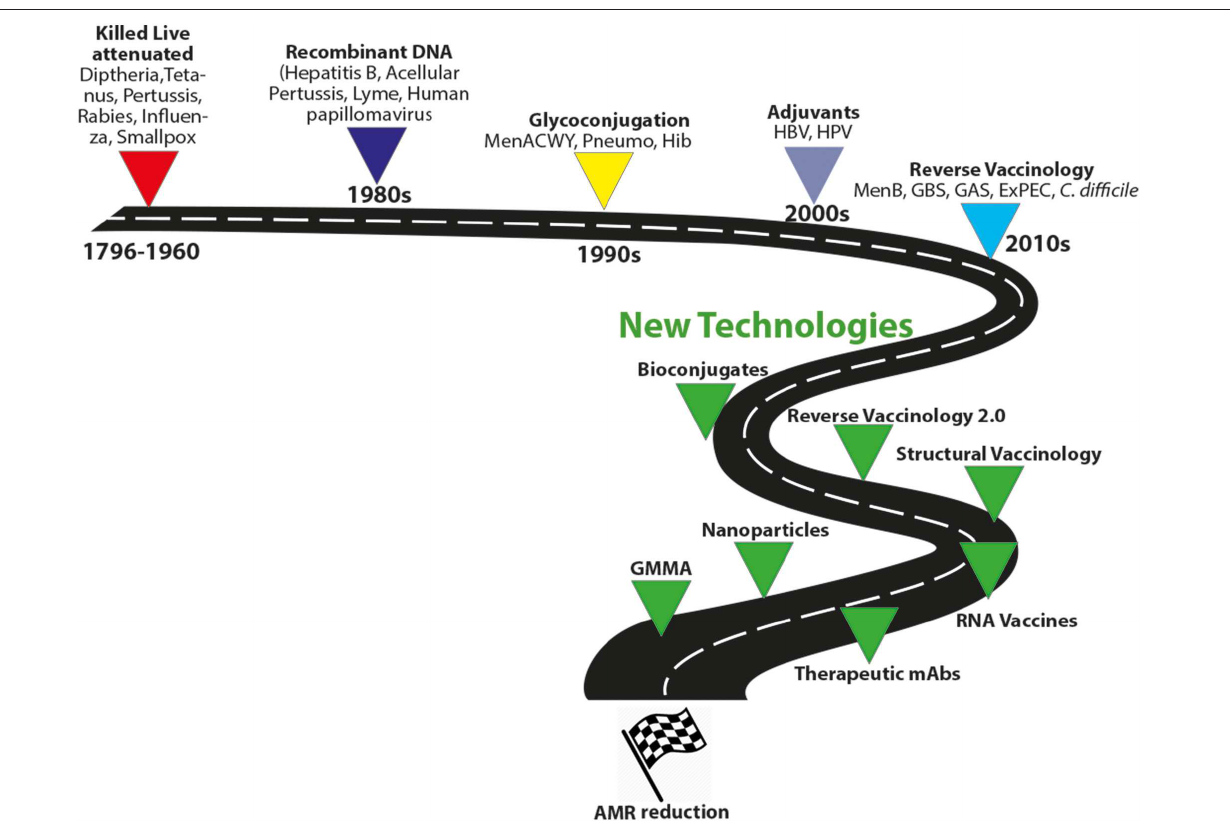
FIGURE 4 | Evolution of vaccine technologies and platforms. MenACWY, meningococcus ACWY; Pneumo, pneumococcus; HBV, hepatitis B virus; Hib, type B Haemophilus influenzae ; GBS, group B Streptococcus, GAS HPV, human papillomavirus; MenB, meningococcus B; GAS, group A streptococcus; ExPEC, extraintestinal pathogenic E. coli ; Generalized Modules for Membrane Antigens, GMMA.